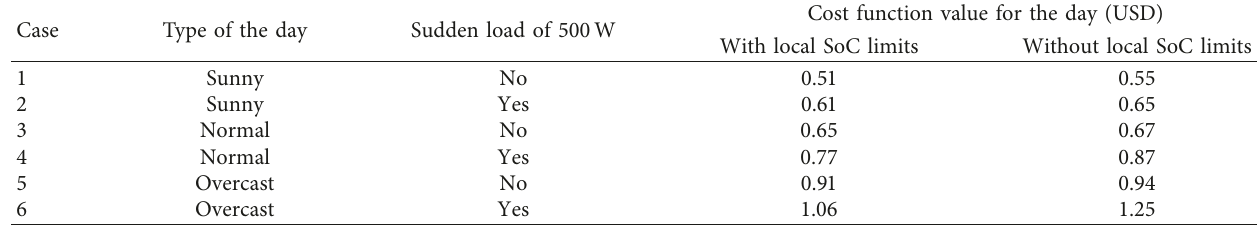
Table 5: Description and the cost comparison of the 6 cases for local SoC limits analysis.